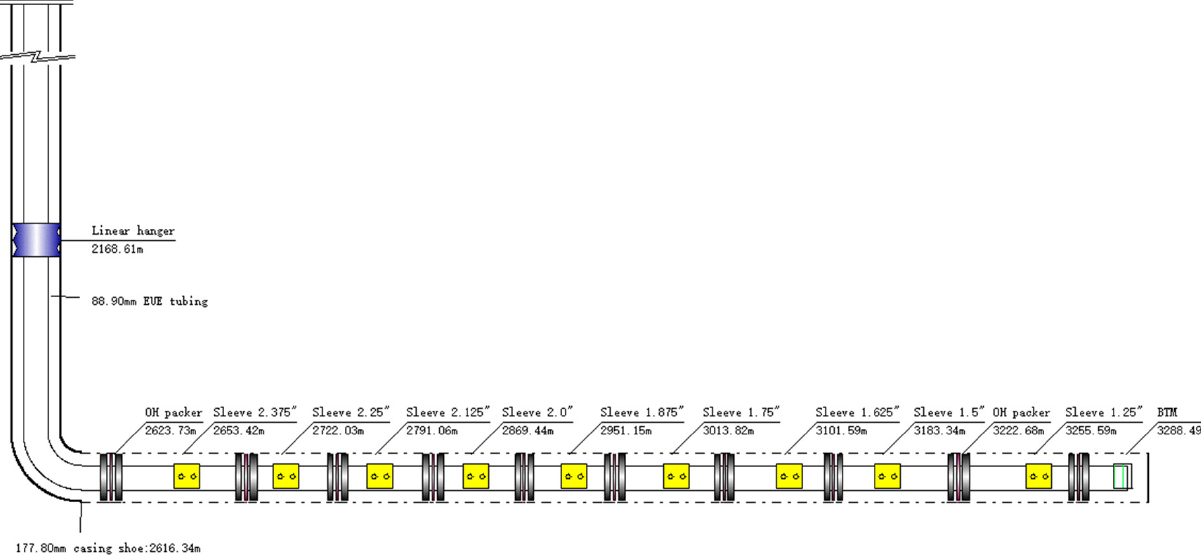
Figure 3. Schematic of open-hole packer multistage fracturing completion string.